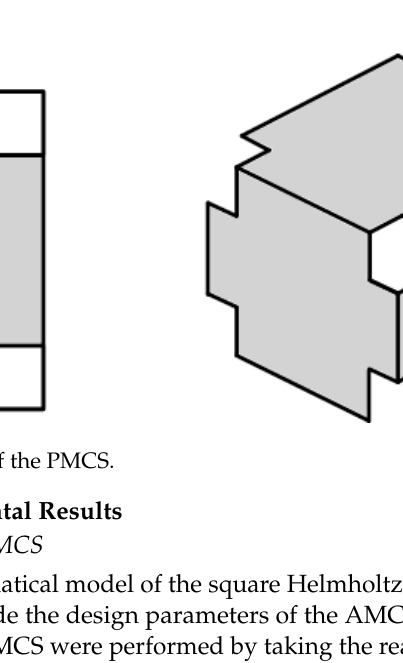
Table 2. The settings of